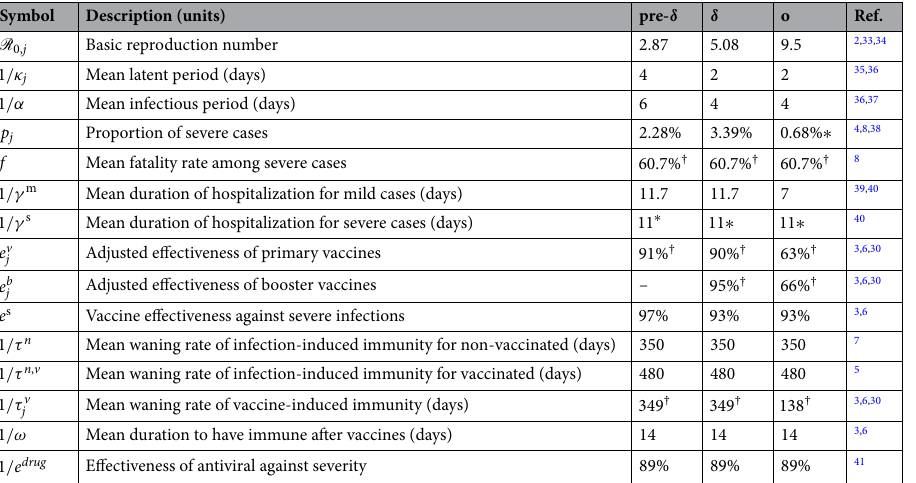
Table 1. The symbols and values used in the mathematical model. The subscripts j = 1, 2, 3 refer to infection with pre-Delta, Delta, and Omicron variants, respectively. *Assumed value. † Calculated